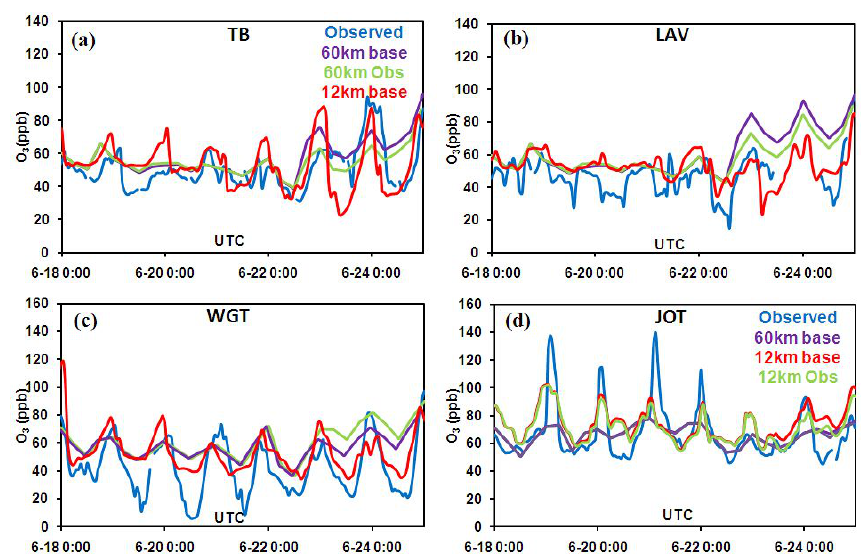
Fig. 17. Observed O 3 time series in comparison with model simulations at (a) TB (b) LAV (c) WGT and (d) JOT during the flight week. Noticeable differences between the Obs case and base case results (60km (a–c); 12km (d)) were